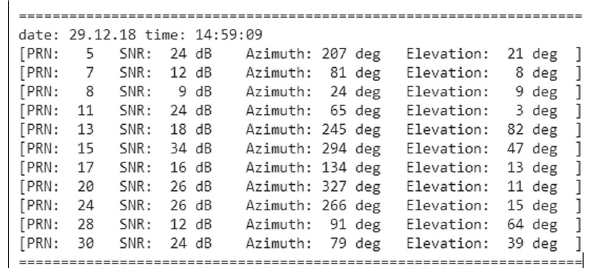
Fig. 7 Example set of the visible satellites coordinates (1 ◦ resolution) extracted from NMEA data captured by G-Mouse USB antenna and logged into text file